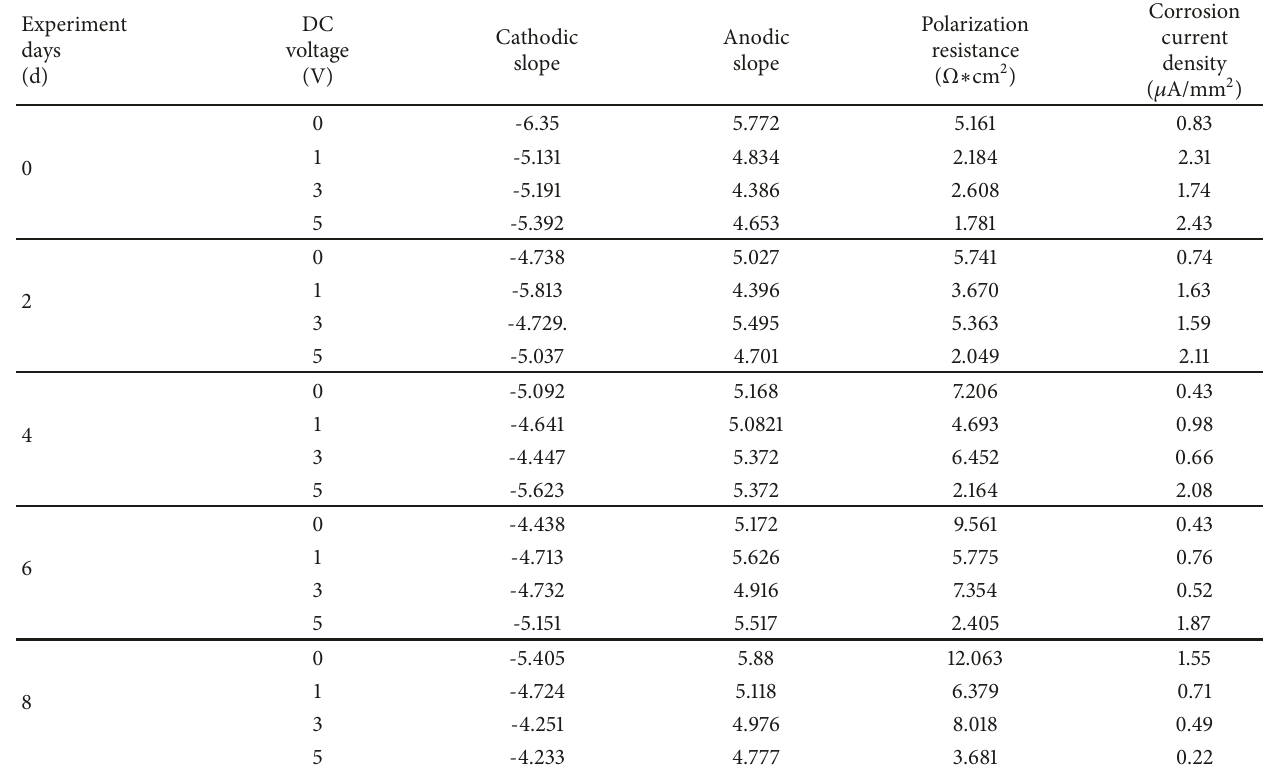
Table 3: The corrosion electrochemical parameters of the sacrificed anode interfered with different DC voltage.